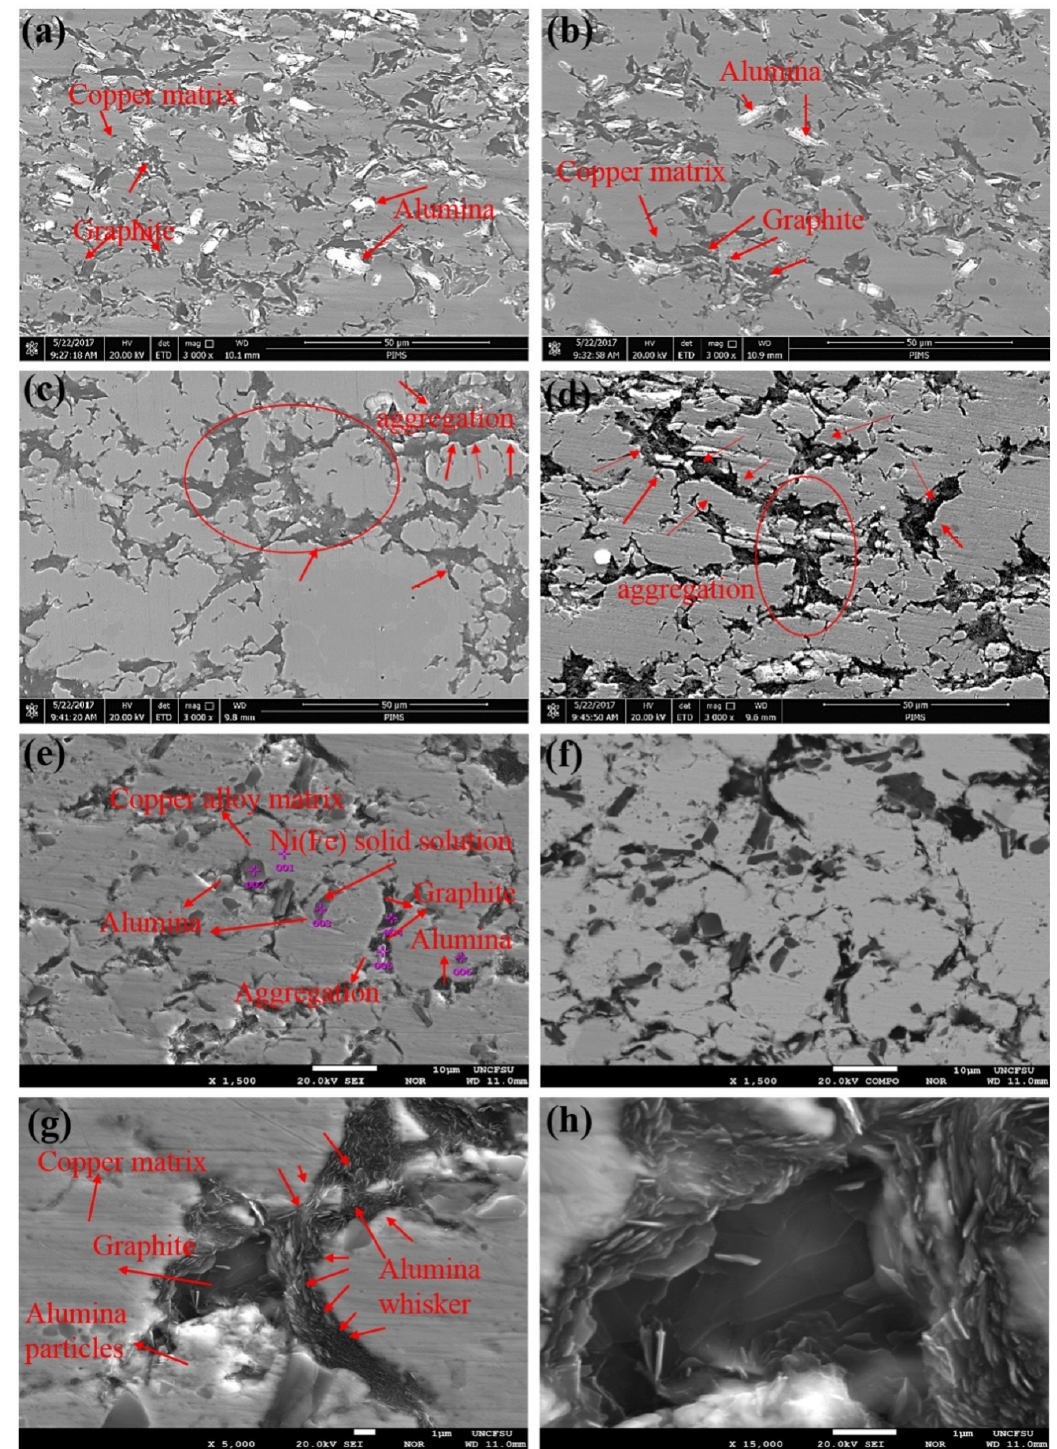
Figure 5. SEM micrographs of sintered composites with different contents of alumina whiskers: ( a ) 0 wt %; ( b ) 0.5 wt %; ( c ) 1 wt %; ( d ) 1.5 wt %; ( e ) SEM micrograph of sintered composites with 0.5 wt % alumina whiskers obtained by electron microprobe microanalysis; ( f ) corresponding backscattered elctrons(BSE) micrograph of ( e ); ( g ) SEM micrographs of sintered composites with 1 wt % alumina whiskers at 15,000×; ( h )corresponding SEM micrograph of ( g ) at 25,000×.